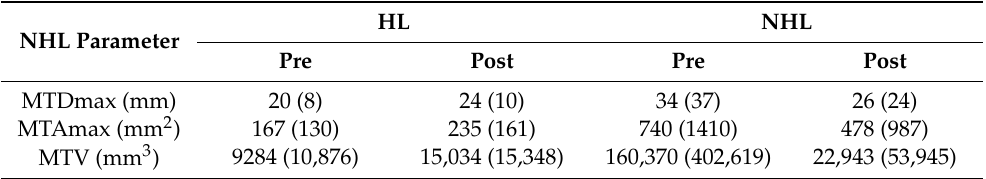
Table 3. Average automated CT size measurements and standard deviations (in parentheses) pre and post treatment for the HL and NHL